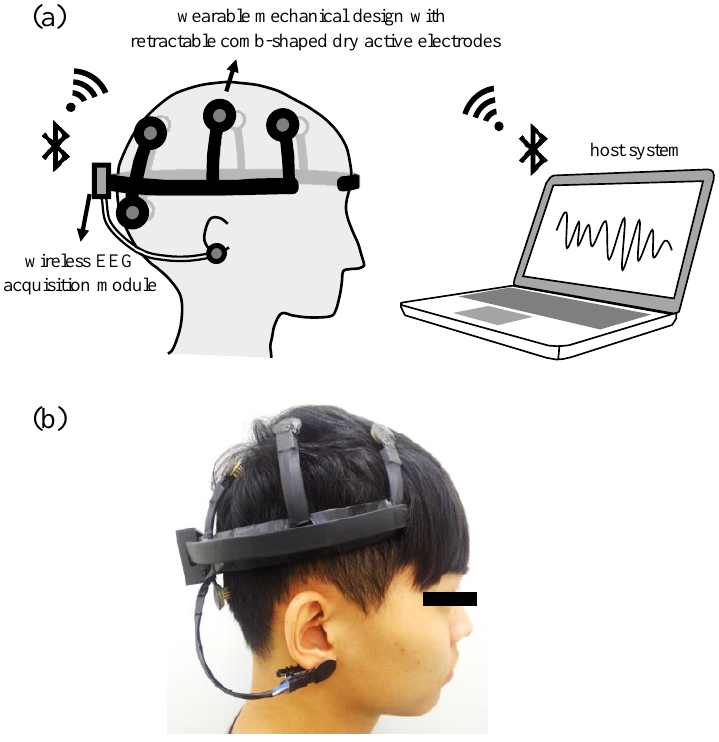
Figure 1. Basic scheme ( a ) and photograph ( b ) of proposed wearable motor-imagery brain-computer interface.